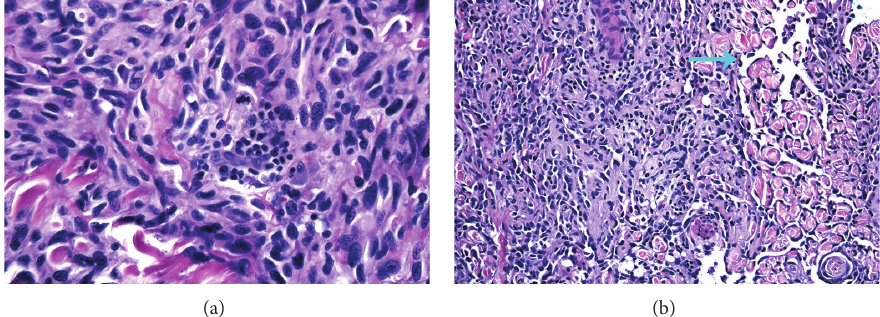
Figure 2: The main tumor was bulky and composed of atypical and pleomorphic spindle cells with numerous mitotic figures (a). On the periphery of the tumor, areas of vessel formation with hyperchromatic and “hob-nailing” (blue arrow) of the neoplastic endothelium were seen (b).